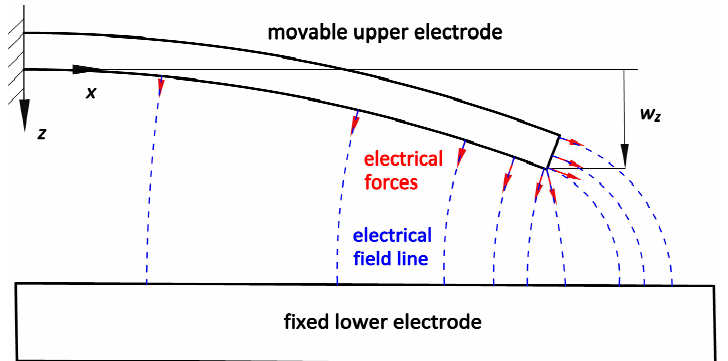
Figure 4. Simulation model of electrostatic MEMS cantilever.